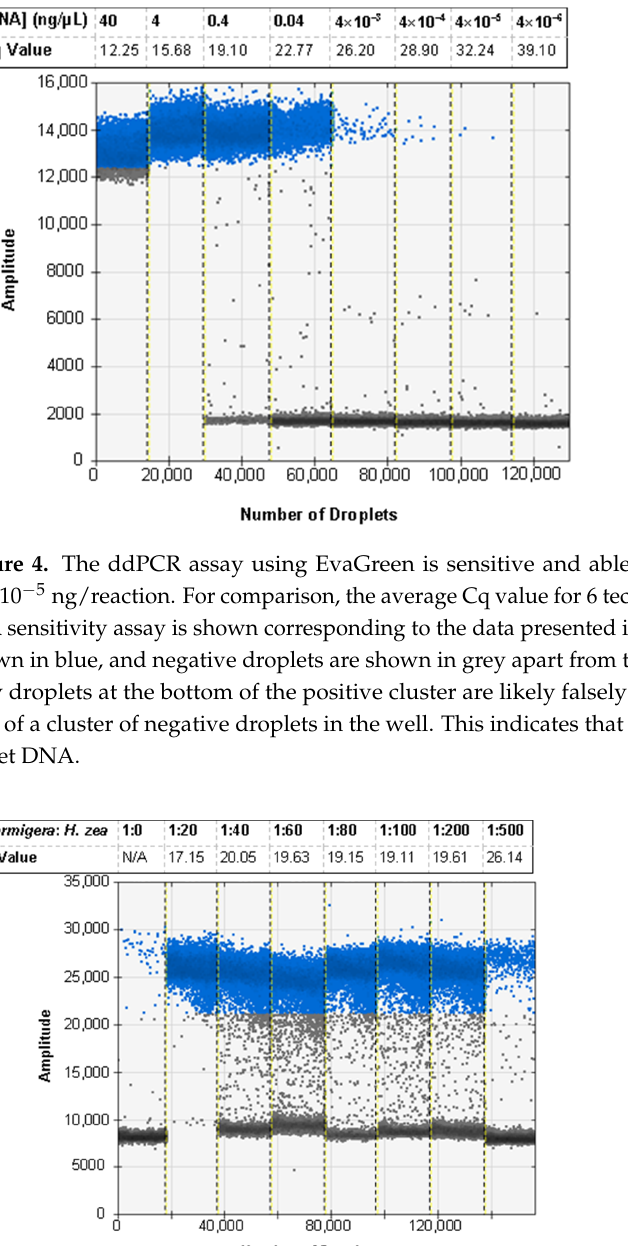
Figure 3. When the probe is used for ddPCR, an alternate cluster of droplets is evident for some samples. ( a ) The cluster (indicated by the black arrow) is prominent between the positive (blue) and negative (grey) droplets in lanes labeled 1 Ha : 80 Hz and 1 Ha : 100 Hz . ( b ) The cluster (indicated by the black arrow) is still evident after assay optimization and use of a touchdown thermocycling program. It is evident in the lanes labeled 0.4 ng Ha 1 and 0.04 ng Ha 1.